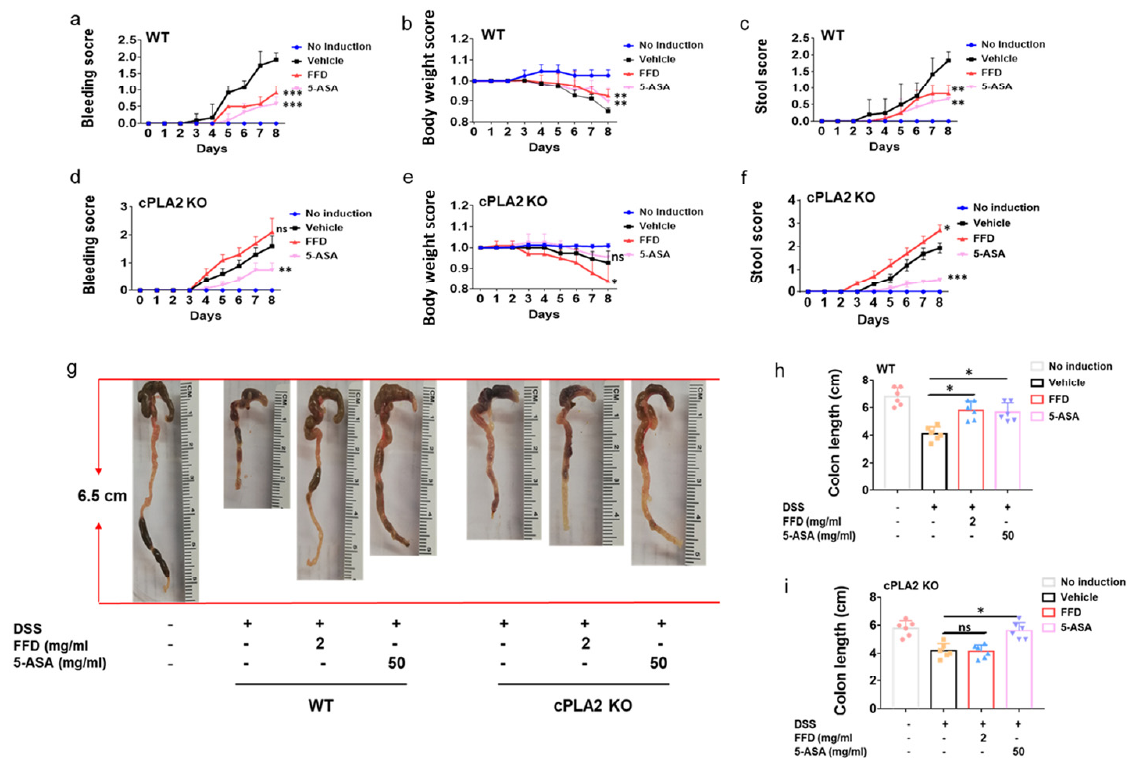
Figure 7. Clinical score of Fexofenadine (FFD)-treated and control groups in DSS-induced cPLA2 KO mice. ( a – c ) Clinical score of controls and FFD-treated WT groups. ( a ) Bleeding scores of controls and FFD-treated WT groups. ( c ) Body weights of controls and FFD-treated WT groups. ( d ) Stool score of controls and FFD-treated WT groups. ( d – f ) Clinical score of controls and FFD-treated cPLA2 KO groups. ( d ) Bleeding scores of controls and FFD-treated cPLA2 KO groups. ( e ) Body weights of controls and FFD-treated cPLA2 KO groups. ( f ) Stool score of controls and FFD-treated cPLA2 KO groups. ( g – i ) Colon lengths of controls and FFD-treated WT or cPLA2 KO groups and the quantification of colon lengths. Statistical analysis was done to compare the treatment groups and vehicle groups. n = 6 per group. Data are mean ± SE; * p < 0.05, ** p < 0.01, *** p < 0.001, ns: not